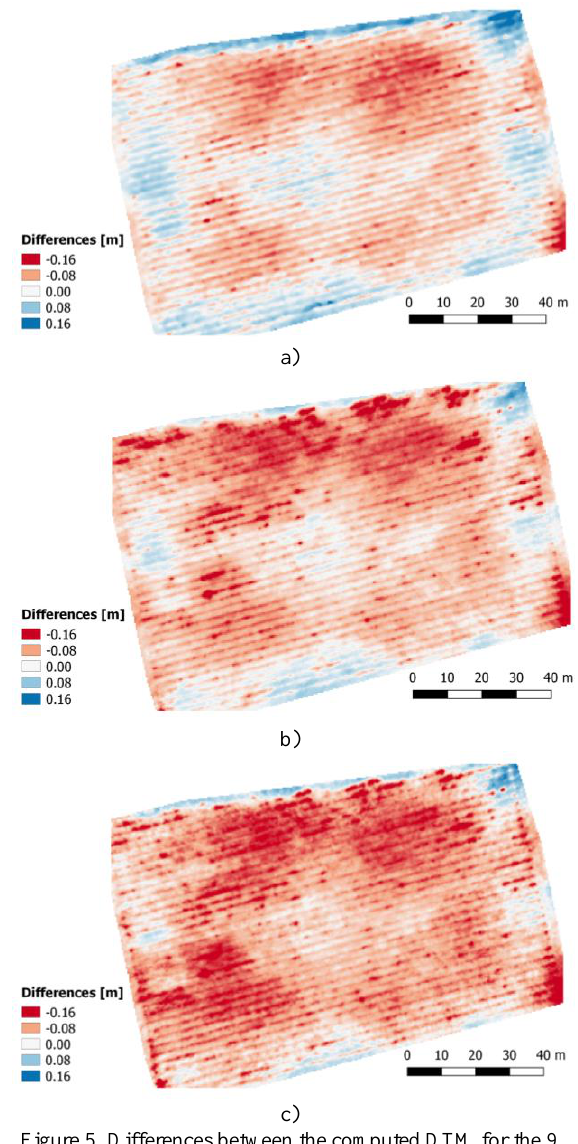
Figure 5. Differences between the computed DTM for the 9